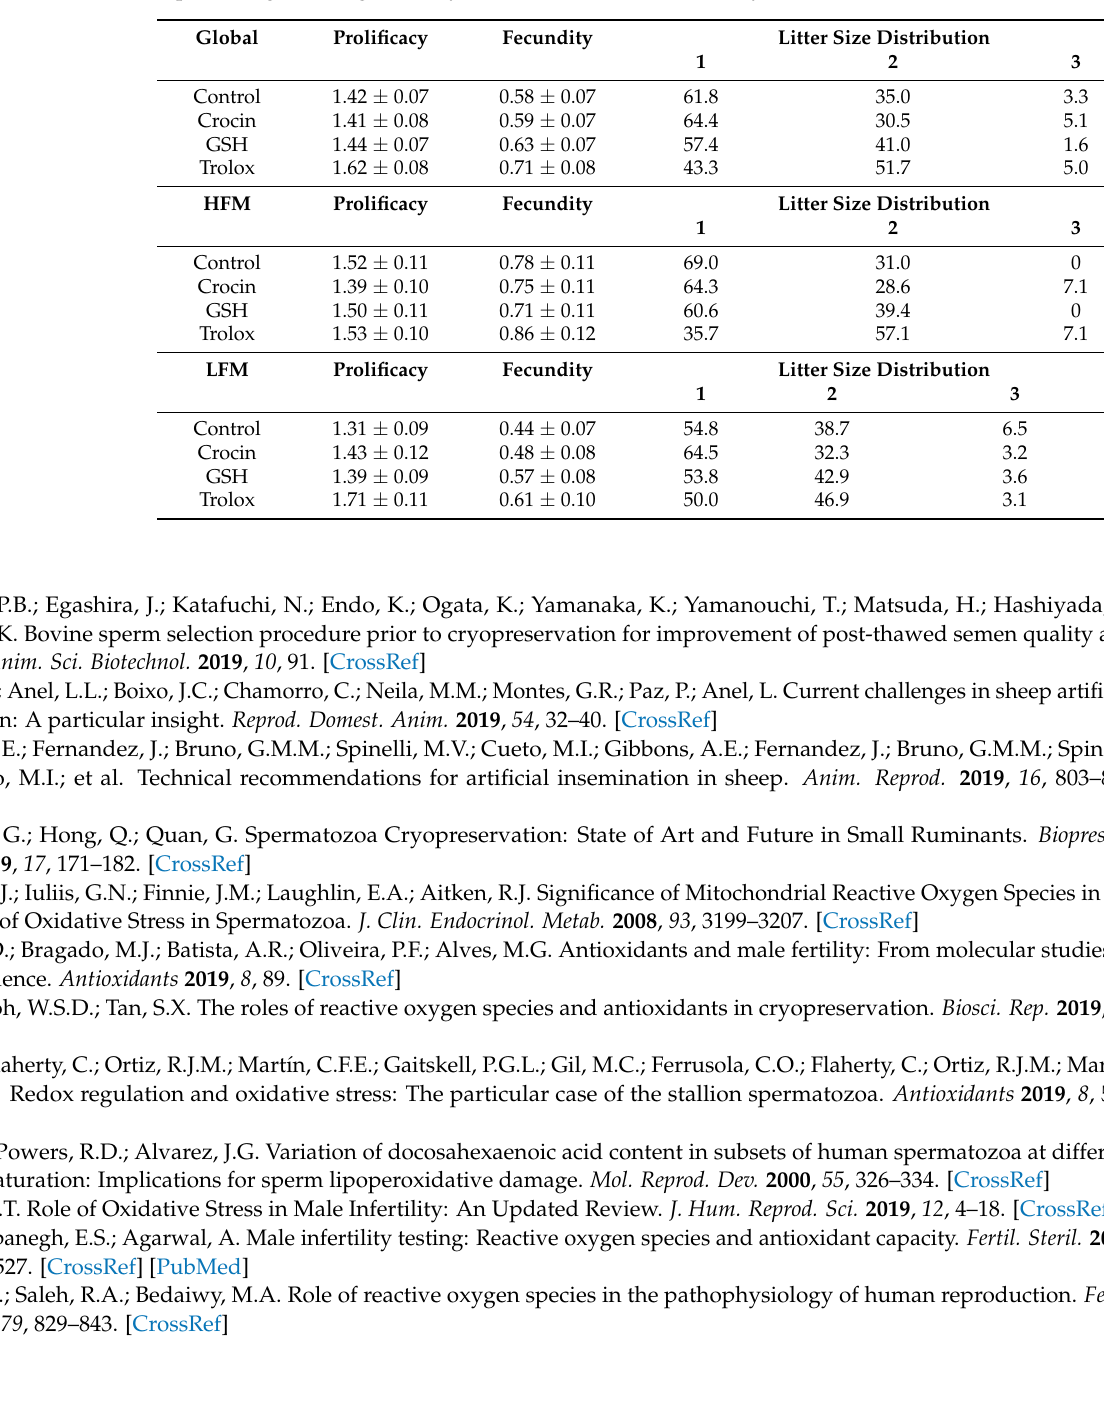
Table A1. Additional fertility parameters obtained after insemination with ram cryopreserved sperm in the four experimental groups (Control-without antioxidant, crocin, GSH and trolox): Prolificacy (Lambs/lambed ewe), Fecundity (Lambs/inseminated ewe) and Litter size distribution. Each table represents global, high fertility males (HFM) and low fertility males (LFM)